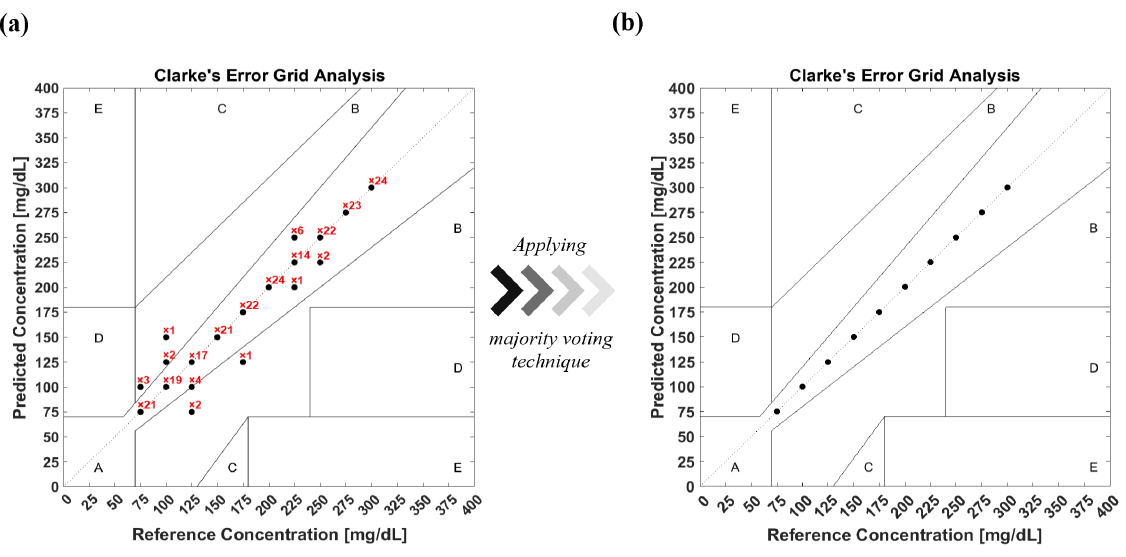
Figure 13. ( a ) Clarke’s EGA of the prediction model with preprocessed data of glucose detection before applying the majority voting algorithm. ( b ) Clarke’s EGA of the prediction model with preprocessed data after applying the majority voting